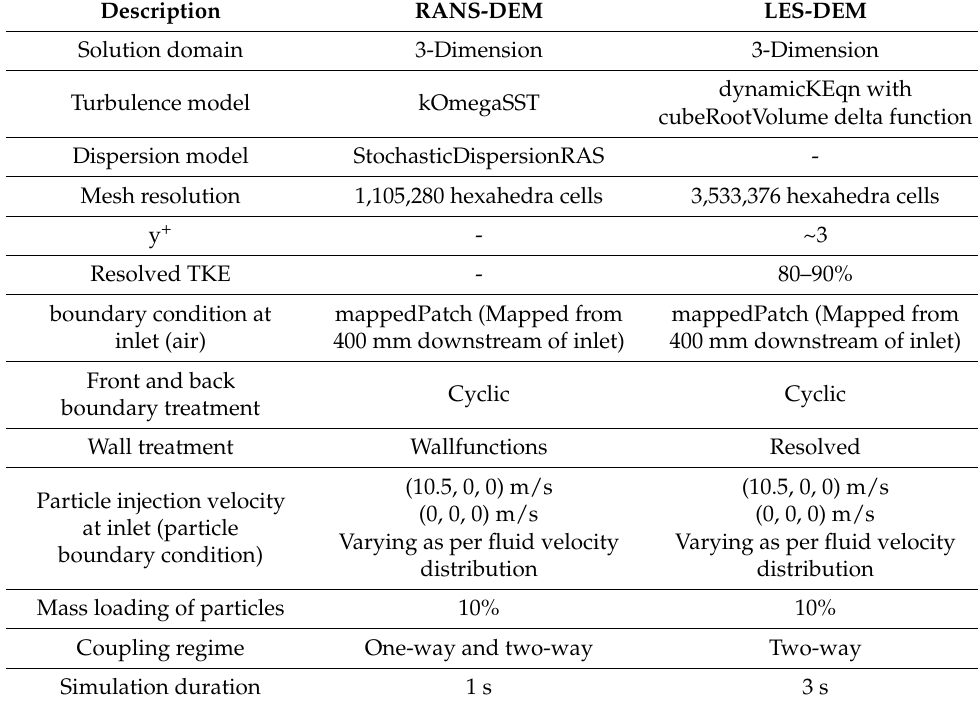
Table 2. RANS-DEM and LES-DEM settings.